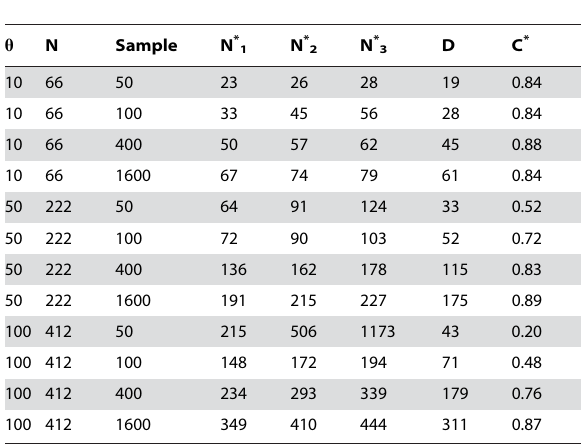
estimation of the number of different haplotypes based on simulated